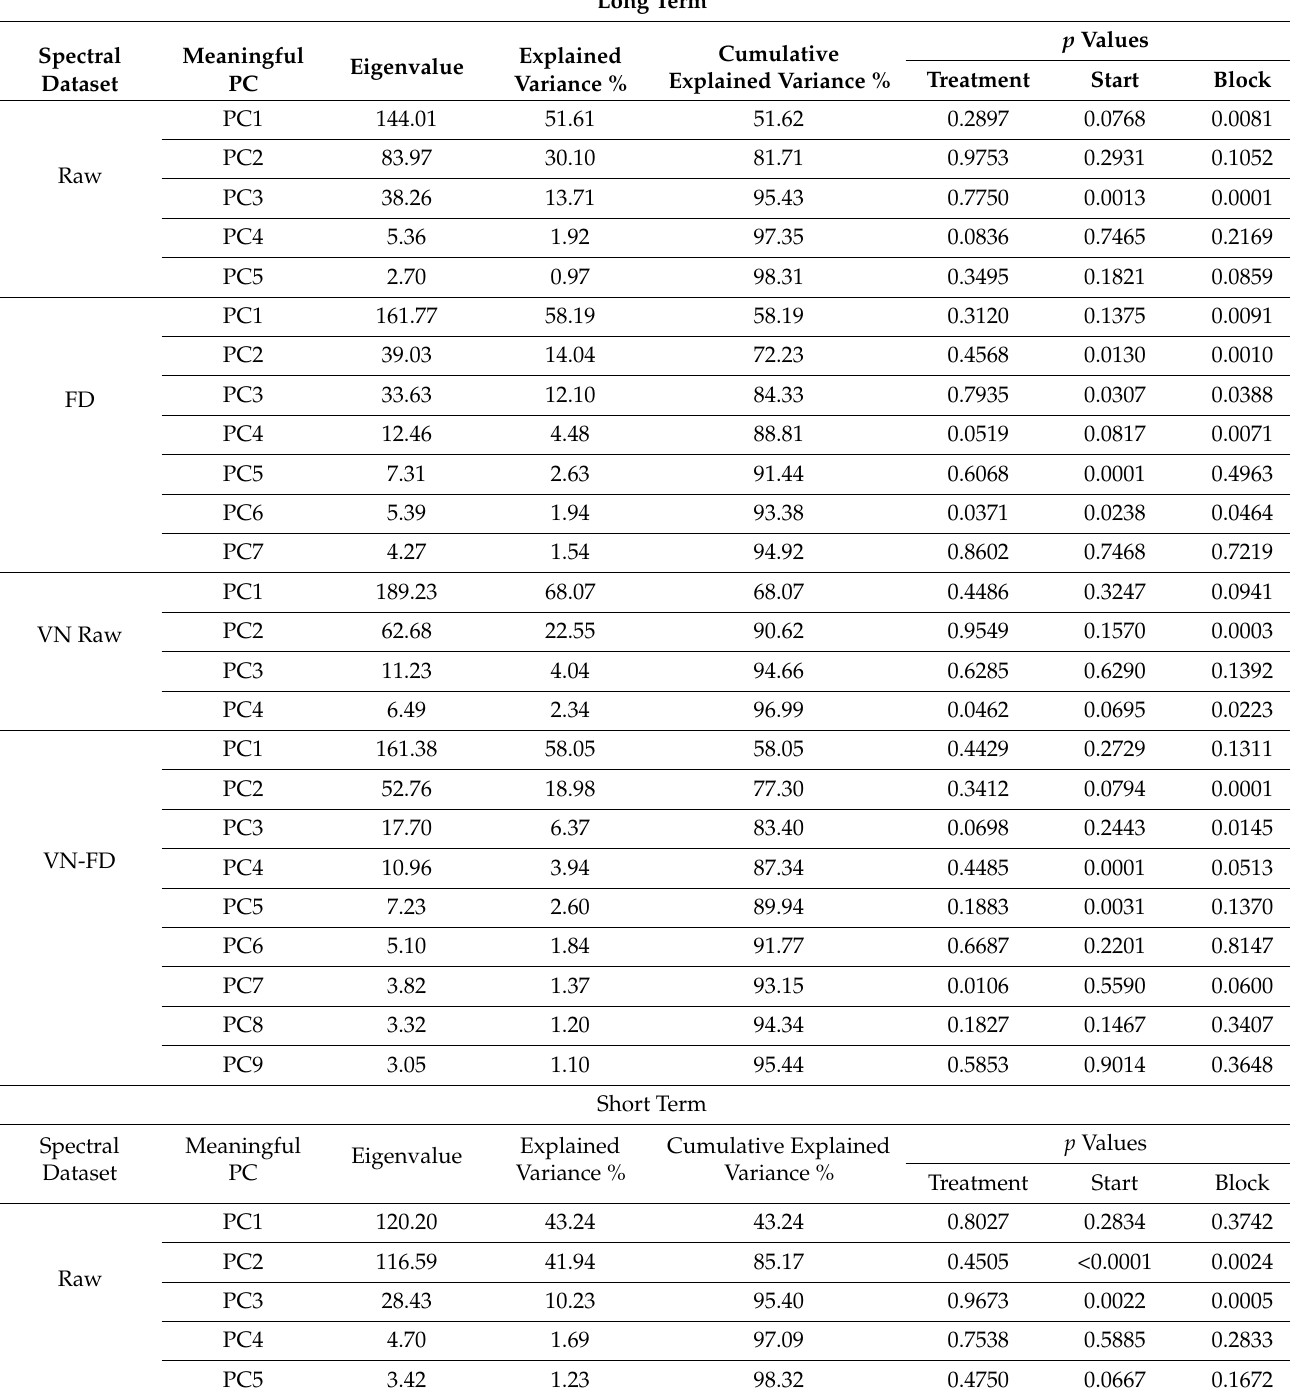
Table 2. Principal components extracted from the raw, FD, vector normalized (VN) raw, VN-FD spectral datasets of the short-term and long-term milk spectral averages for the tie-rail trial. The table also lists p values obtained from the SAS mixed procedure for the treatment, start and block effects that are tested in this trial. Values in bold indicate principal components that revealed significant treatment